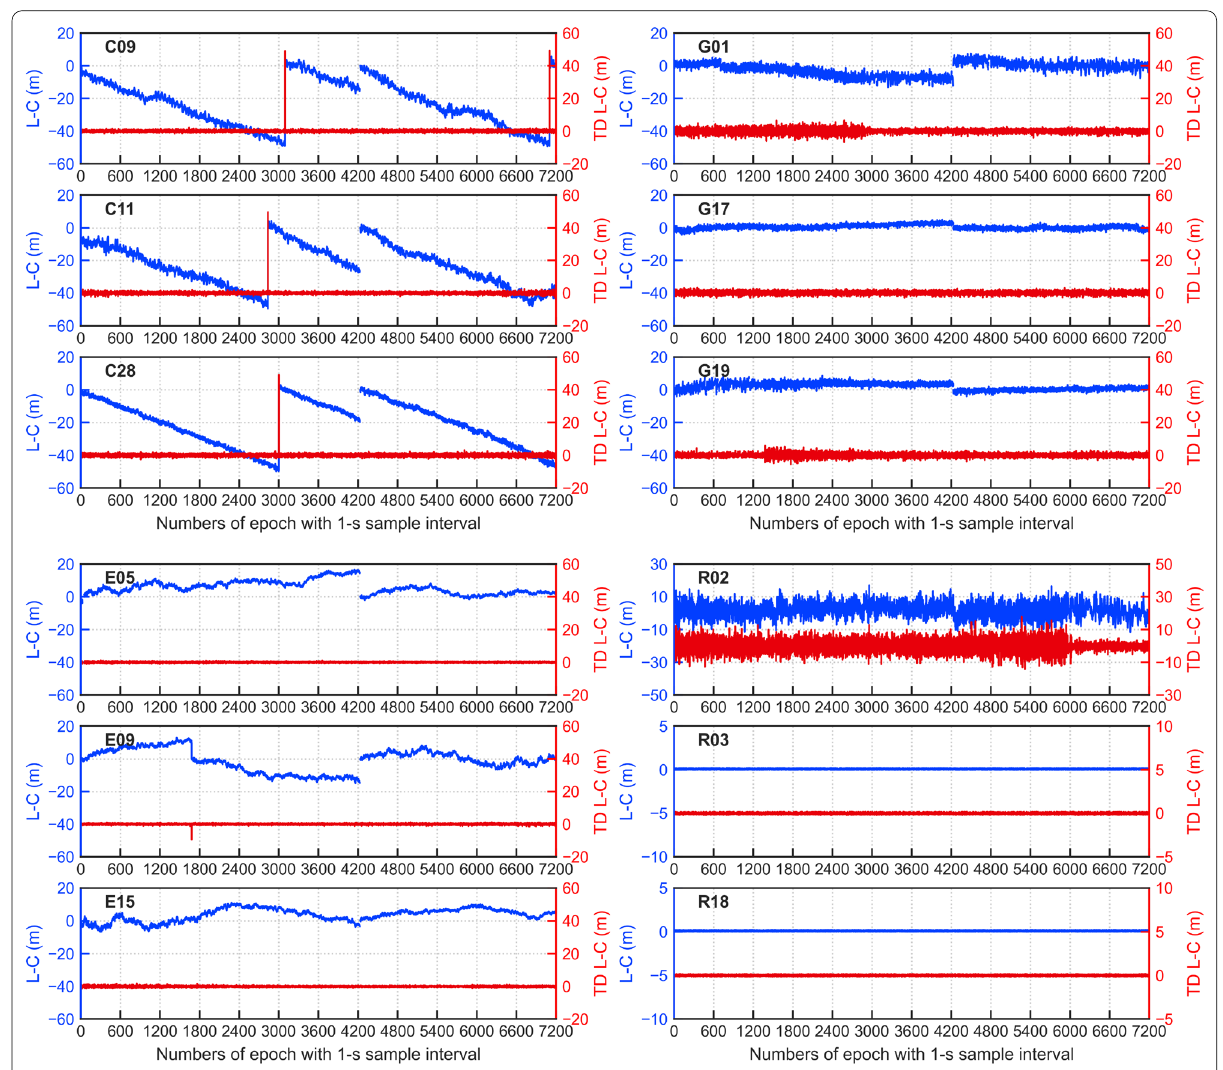
Fig. 11 Phase minus code combinations (blue) and time-differenced values (red) of BDS, GPS, Galileo and GLONASS satellites